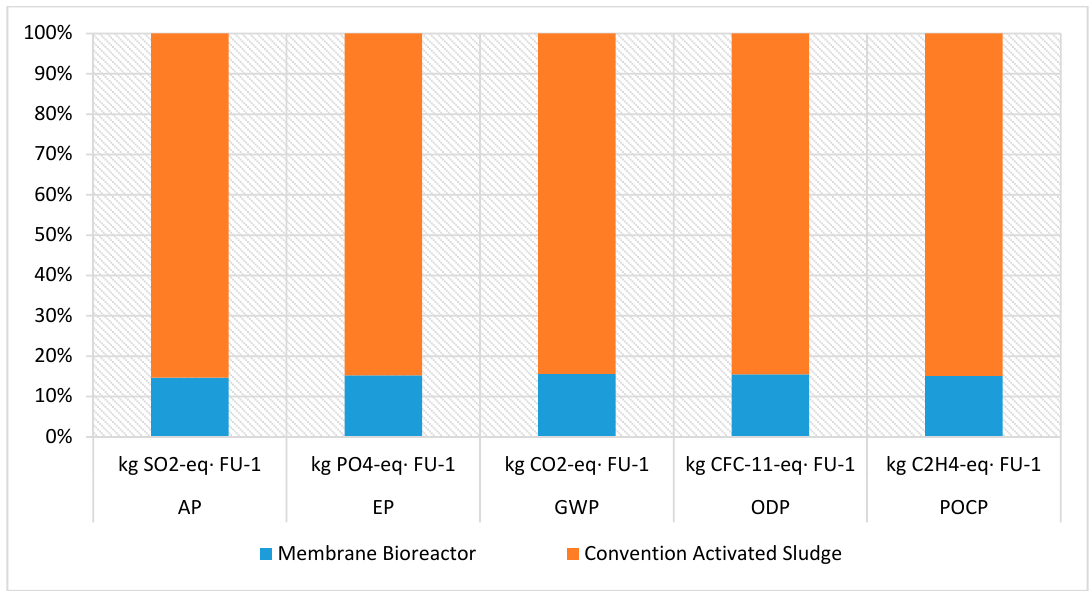
Figure 4. Comparative LCIA for the two units. Table 5. LCIA with no wastewater treatment plant life cycle contribution.